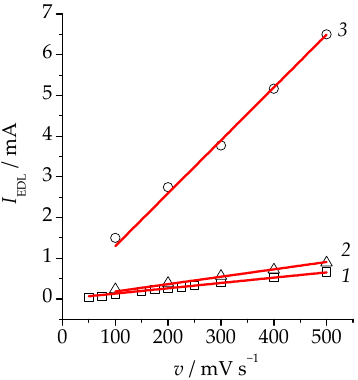
Figure 1. Dependence of the charging current of the EDL at E = 50 mV on the potential scan rate, obtained in 0.5 M H 2 SO 4 for (1)—unmodified alloy, (2)—anodically modified Cu 85 Pd 15 ( E mod = 630 mV, q mod = 24 mC·cm − 2 ) alloy, and (3)—anodically modified Cu 85 Pd 15 ( E mod = 630 mV, q mod = 480 mC·cm − 2 ) alloy.